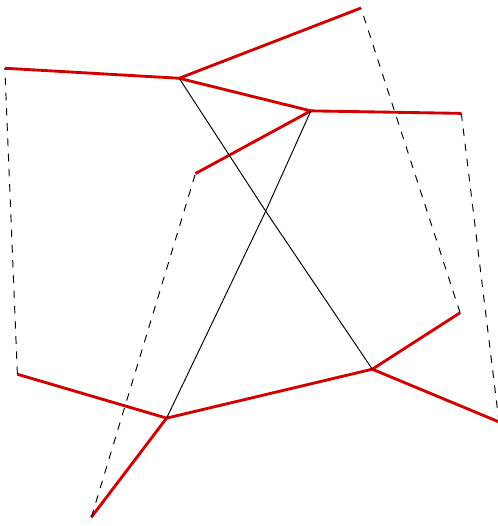
Figure 1 . The elementary recombination for D = 2 (sometimes called an F -move or crossing relation), drawn here as relating the red foam at bottom to the red foam at top, is captured by a point-like singularity of a three dimensional foam which is Poincaré dual to a tetrahedron and for which the initial and final foams form the top and bottom